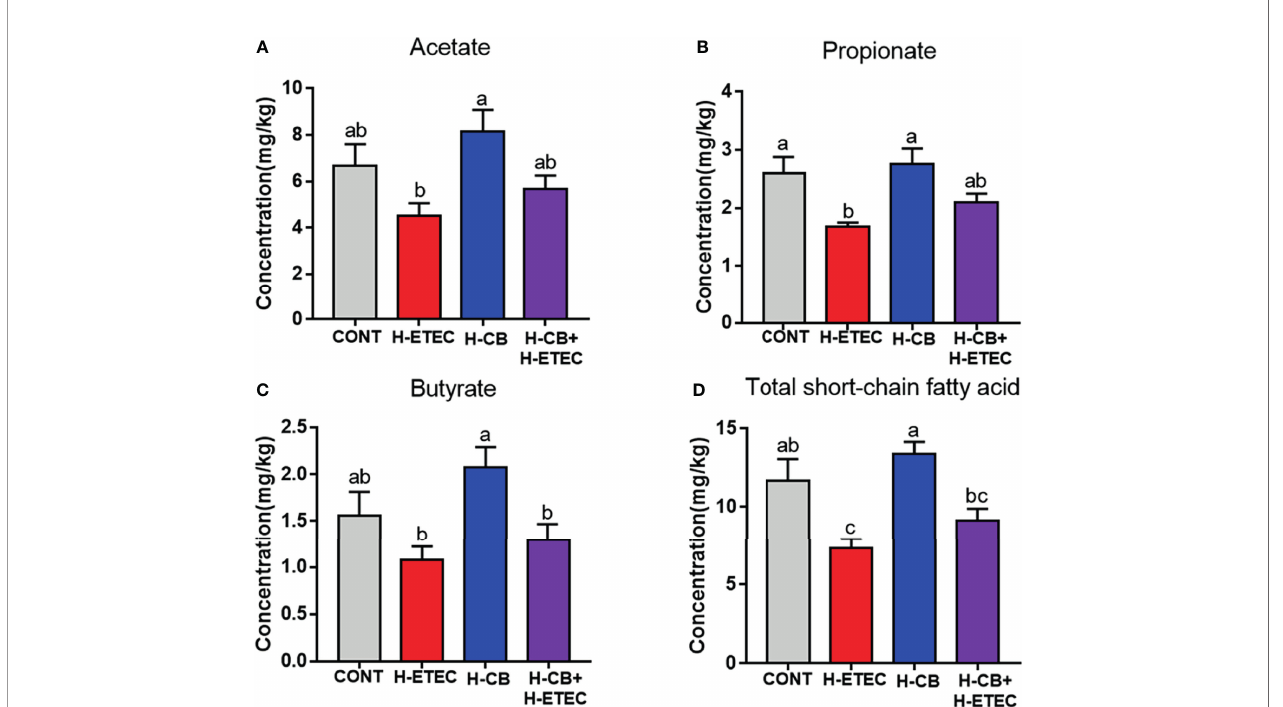
FIGURE 8 | Effects of CB and/or ETEC K88 on (A) acetate, (B) propionate, (C) butyrate and (D) total short-chain fatty acids in the cecum of mice (n = 3 mice per group). Values shown are the means ± SEM. Different small letters indicate signi fi cant differences ( p <